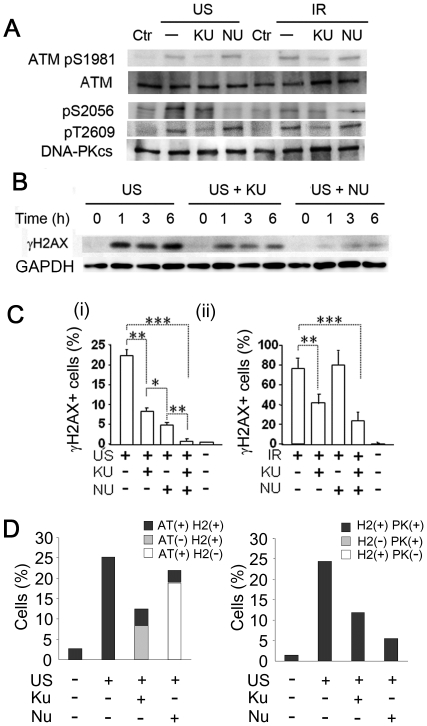
Effects of KU55933 (KU) and NU7026 (NU) on US- or IR-induced γH2AX signaling.(A) Immunoblots of U937 cell extracts 30 min after US or IR and effects of KU and NU on ATM pS1981 and DNA-PKcs pS2056/pT2609. (B) Greater suppression of US-induced γH2AX by NU than KU up to 6 h after US in U937 cells in WB analysis. (C) Effects of KU and/or NU: a greater suppression of US-induced γH2AX+ cells by NU than KU, and abrogation by KU-plus-NU in FCM analysis. (n = 3, mean ± s.d.). *, P<0.05; **, P<0.01; ***, P<0.001. Cells were treated with KU and/or NU (10 µmol/L) for 1 h before and after exposure to 0.3 W/cm2 US (i) or 10 Gy IR (ii). (D) DNA-PK preceded ATM for γH2AX induction by US: a preferential role of DNA-PK in γH2AX induction was determined by immunostaining. Cells were treated as Fig. 4C. ATM pS1981 (AT), DNA-PKcs pS2056 (PK), and γH2AX (H2) positive/negative cells were counted at least 100 cells in each experiment. The data shows the averages from 2 independent experiments.